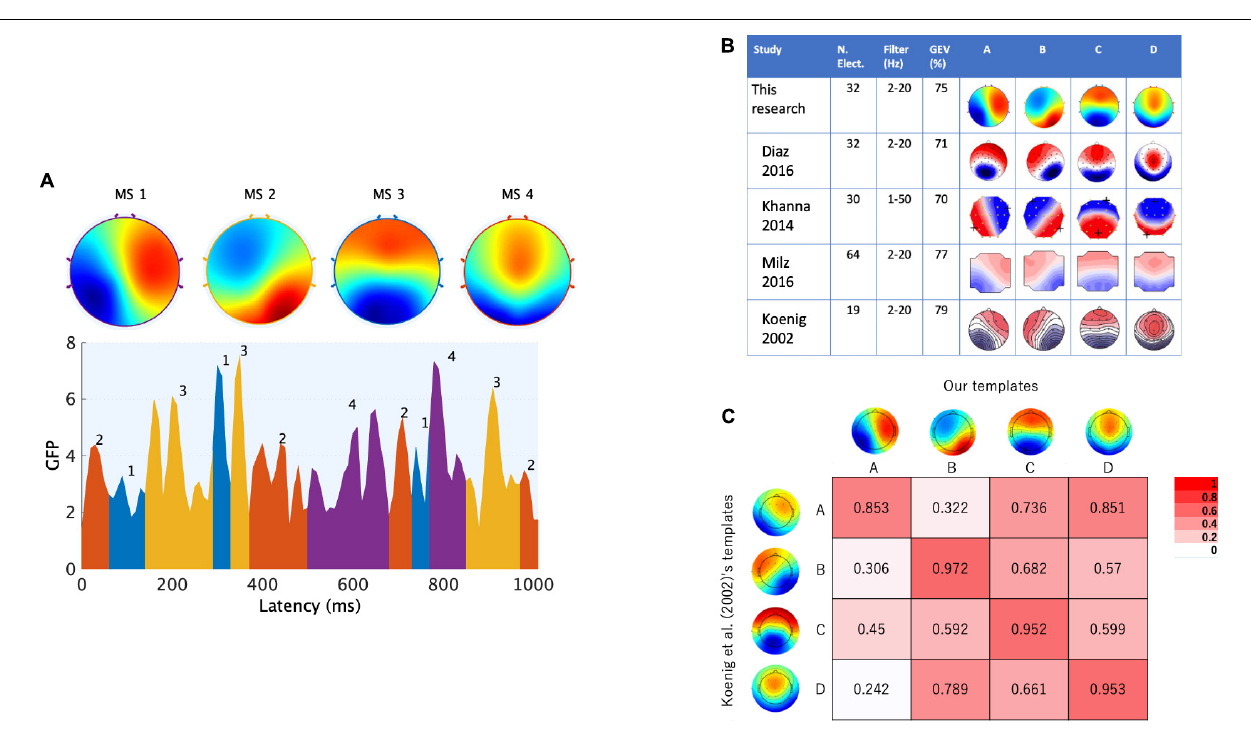
FIGURE 2 | Canonical EEGms templates as the targeted states in neurofeedback. The microstate maps obtained from external participants under the eyes-closed resting state are shown. (A) Four maps are identified through a typical microstate analysis (upper) based on the GFP (global field power) peak dataset (lower). The sequences of microstate classes were determined by back-fitting to the data with the highest topographical correlation (see text for details). (B) These canonical templates were spatially congruent with previous studies, regardless of the EEG measurement or analysis tools. (C) Polarity-ignored spatial similarity (Pearson’s | r|) with normative templates in which both configurations were interpolated onto 67 × 67